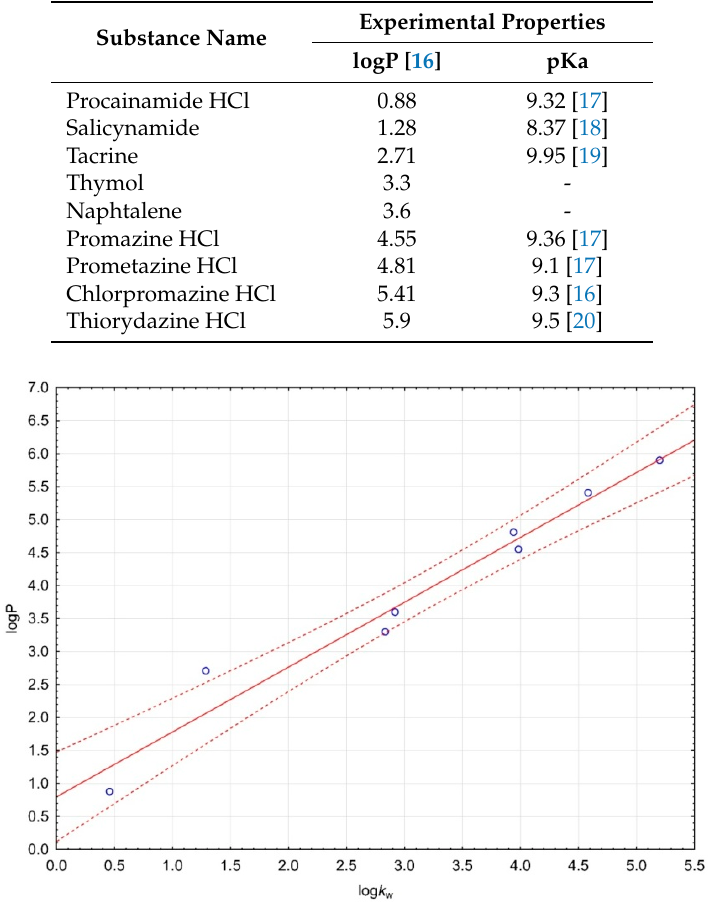
Figure 3. Calibration curve for logP assay. The regression line is marked on the continuous line. Dashed lines determine the area of regression belt at the confidence level 0.95.